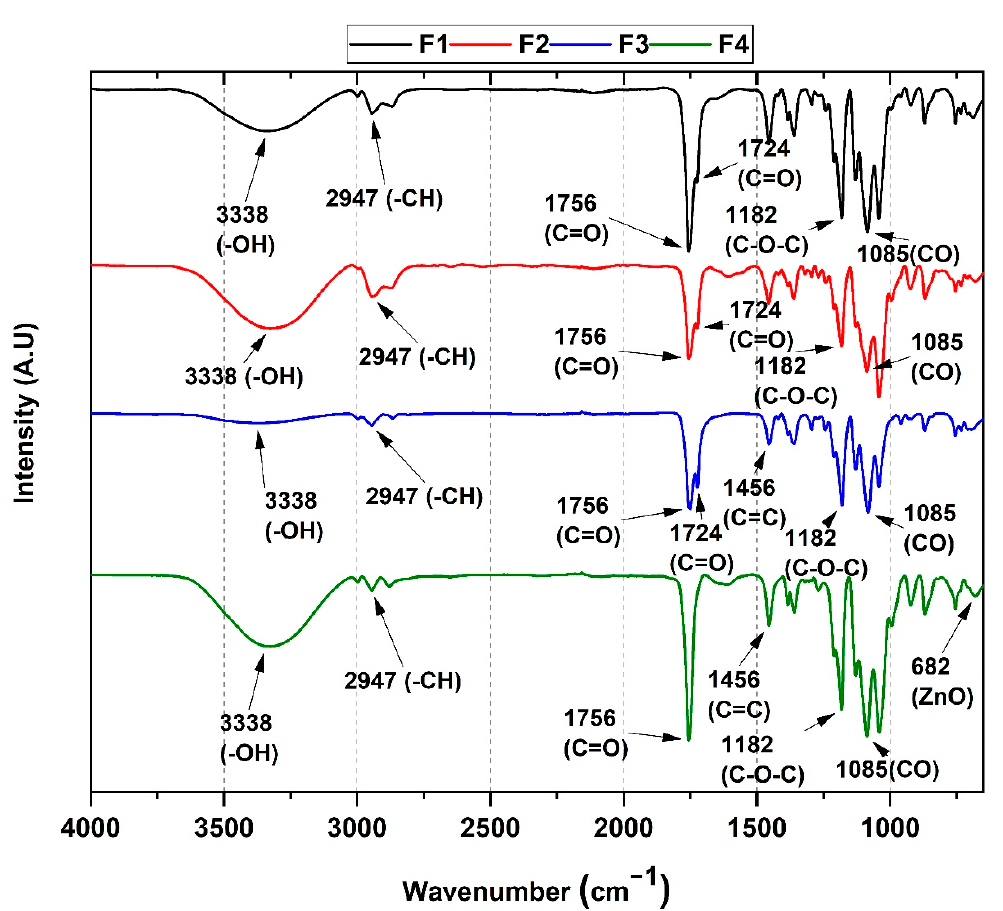
Figure 5. FT-IR spectrum of PCL/PLA/ZnO-NPs/Gly/TTEO nanocomposites. F1, 25%PCL/70%PLA/5%Gly; F2, 22%PCL/70%PLA/5%Gly/3%ZnO-NPs; F3, 15%PCL/70%PLA/5%Gly/10%TTEO; F4, 17%PCL/70%PLA/5%Gly/3%ZnO-NPs/10%TTEO.